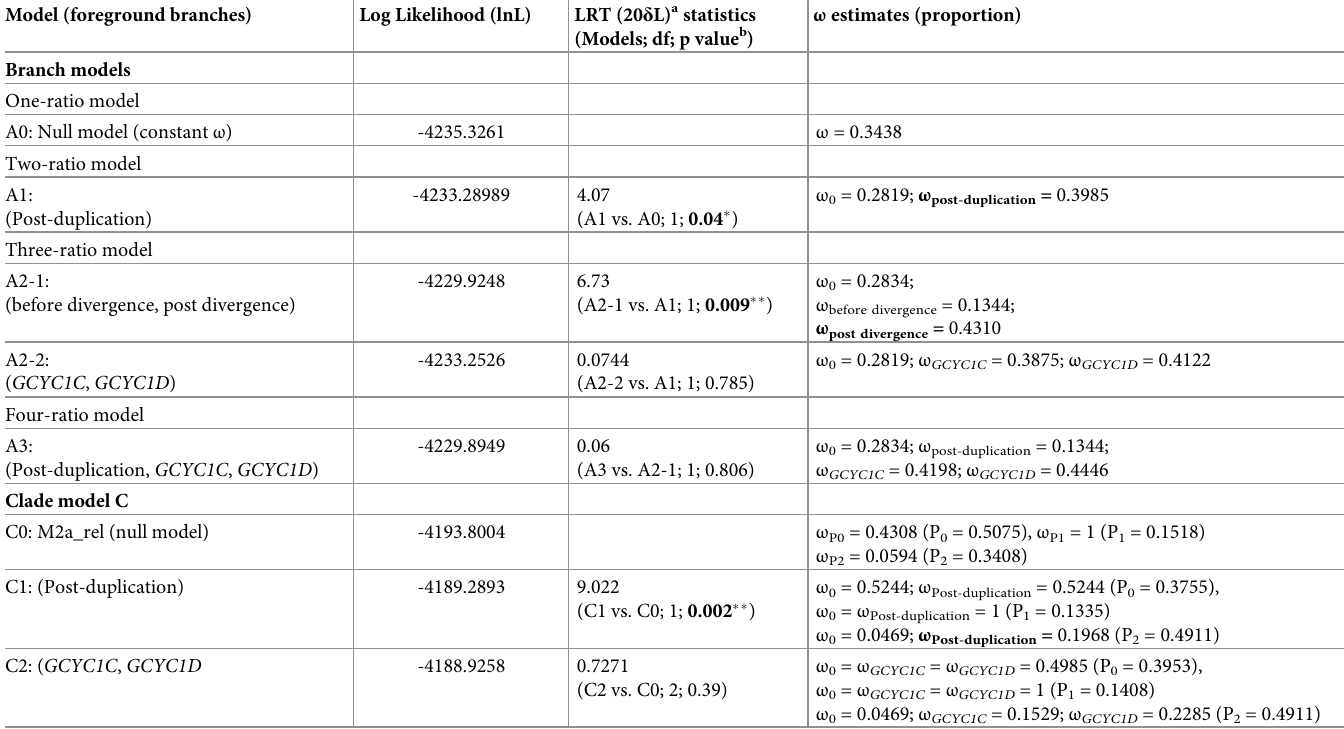
Table 1. Parameter estimates under branch and branch-site models of GCYC1C and GCYC1D in tribe Trichosporeae. Model (foreground